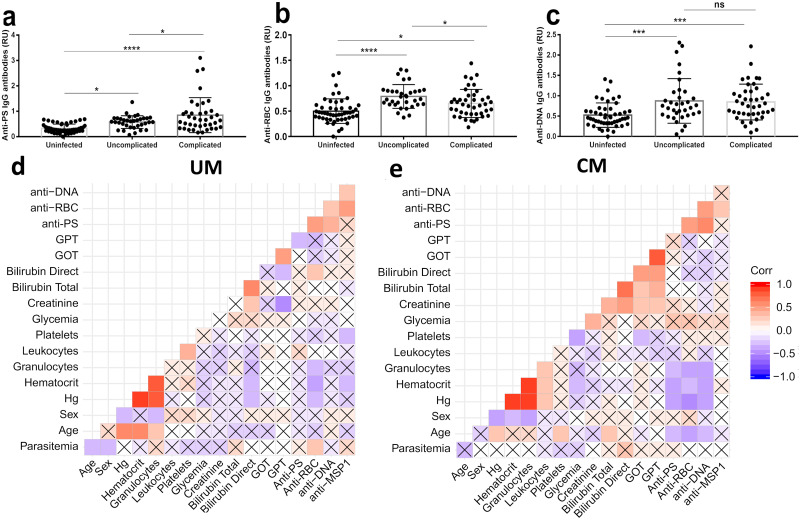
Correlation analysis of autoantibodies with epidemiological and clinical parameters in P. vivax patients with uncomplicated or complicated malaria.Bar graphs representing the levels of anti-PS (a), anti-RBC lysate (b) or anti-DNA (c) IgG antibodies in uninfected, uncomplicated or complicated P. vivax patients from cohort 2. A correlation matrix shows that anti-RBC, anti-PS and anti-DNA, but not anti-MSP1, correlate inversely with hemoglobin (Hg) in patients with complicated (CM) P. vivax (e), but not in uncomplicated (UM) (d). Spearman correlation coefficients are shown using the scale shown on the right, with positive correlations shown in red and negative correlations shown in blue. Boxes are marked with an “X” to show that the p-value for these pairwise correlations was >0.05. Significance assessed by One-way Anova (a-c) or non-parametric Spearman Correlation (d-e). *p≤0.05, **p≤0.01, ****p≤0.0001.